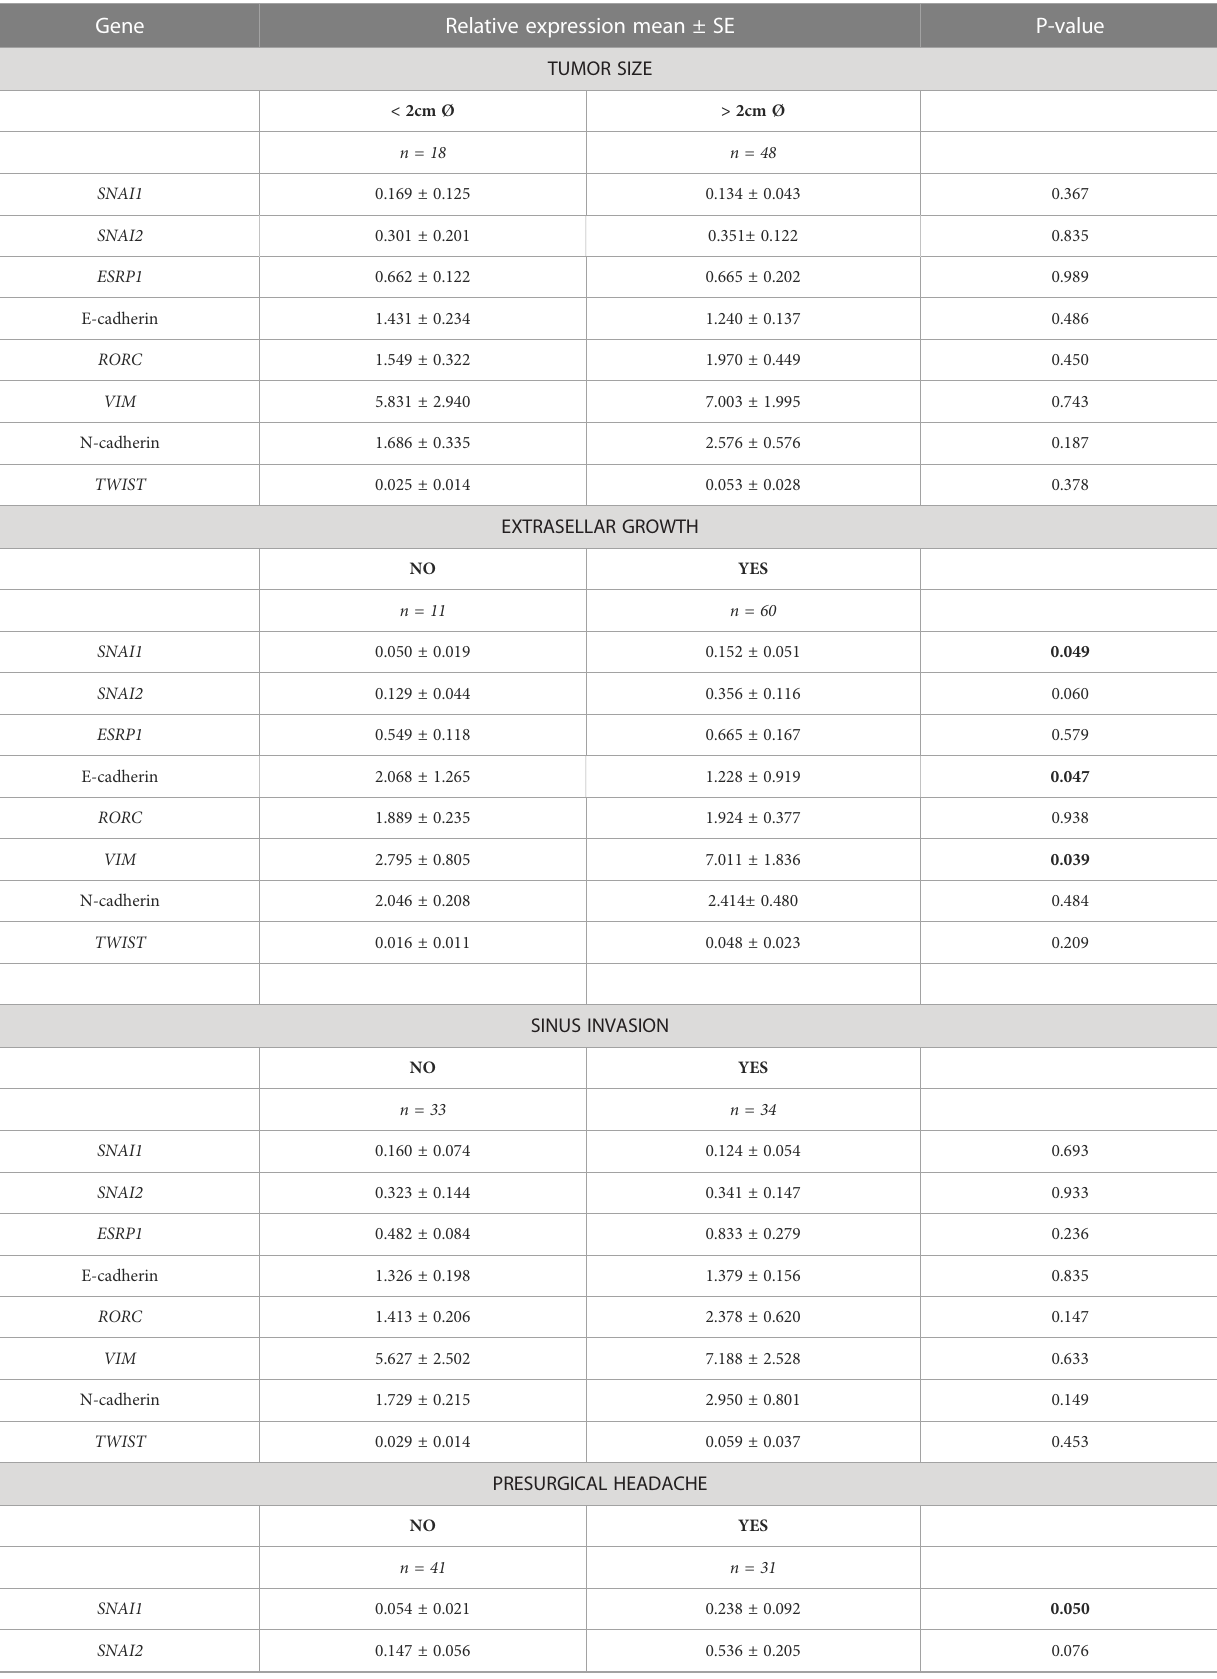
TABLE 2 Association between the relative expression of each EMT marker and different tumor